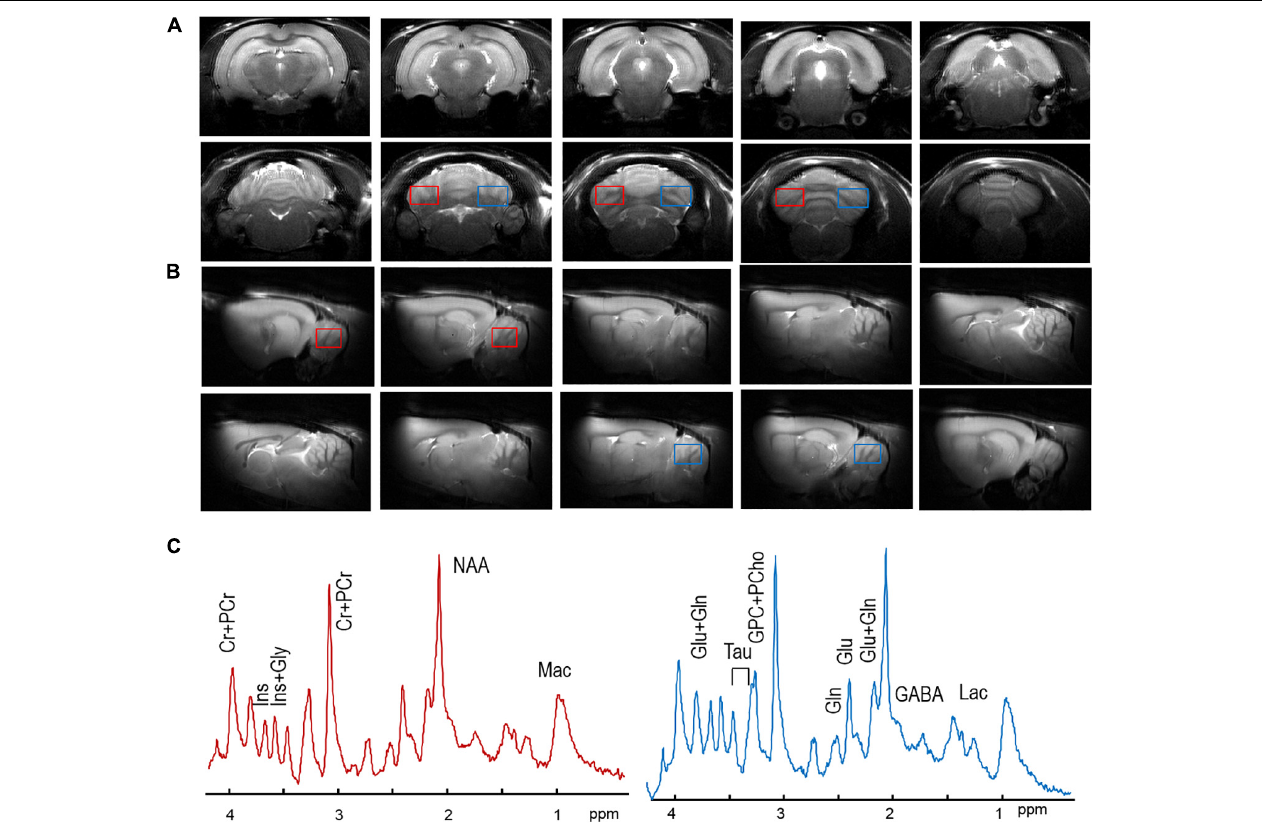
FIGURE 1 | Typical axial (A) and sagital (B) MR images, and one of each spectrum from the right cerebellum (red boxes) and the left cerebellum (blue boxes) in and (B) of one SH rat. In panel (C) , no visual difference was observed between the right cerebellar spectrum (in solid red line) and the left one (in solid blue line). No visual differences in MR spectra were observed. Major metabolic resonances were highlighted along with their abbreviations, as listed in the Section “Materials and